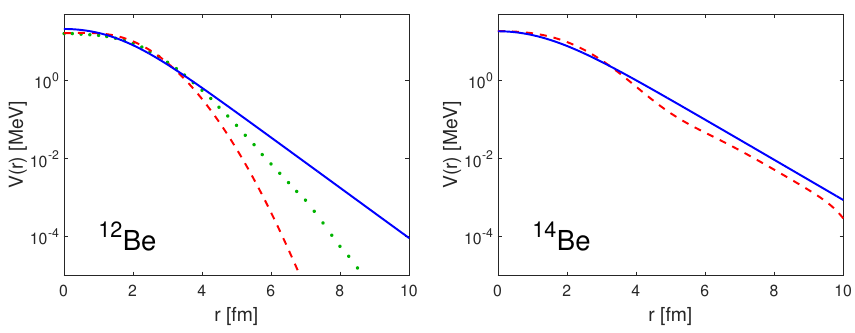
Figure 2. The real parts of optical potentials for 12 Be + p (left) and 14 Be + p (right) scattering calculated using the SF (blue solid), VMC (green dotted) and GCM (red dashed)